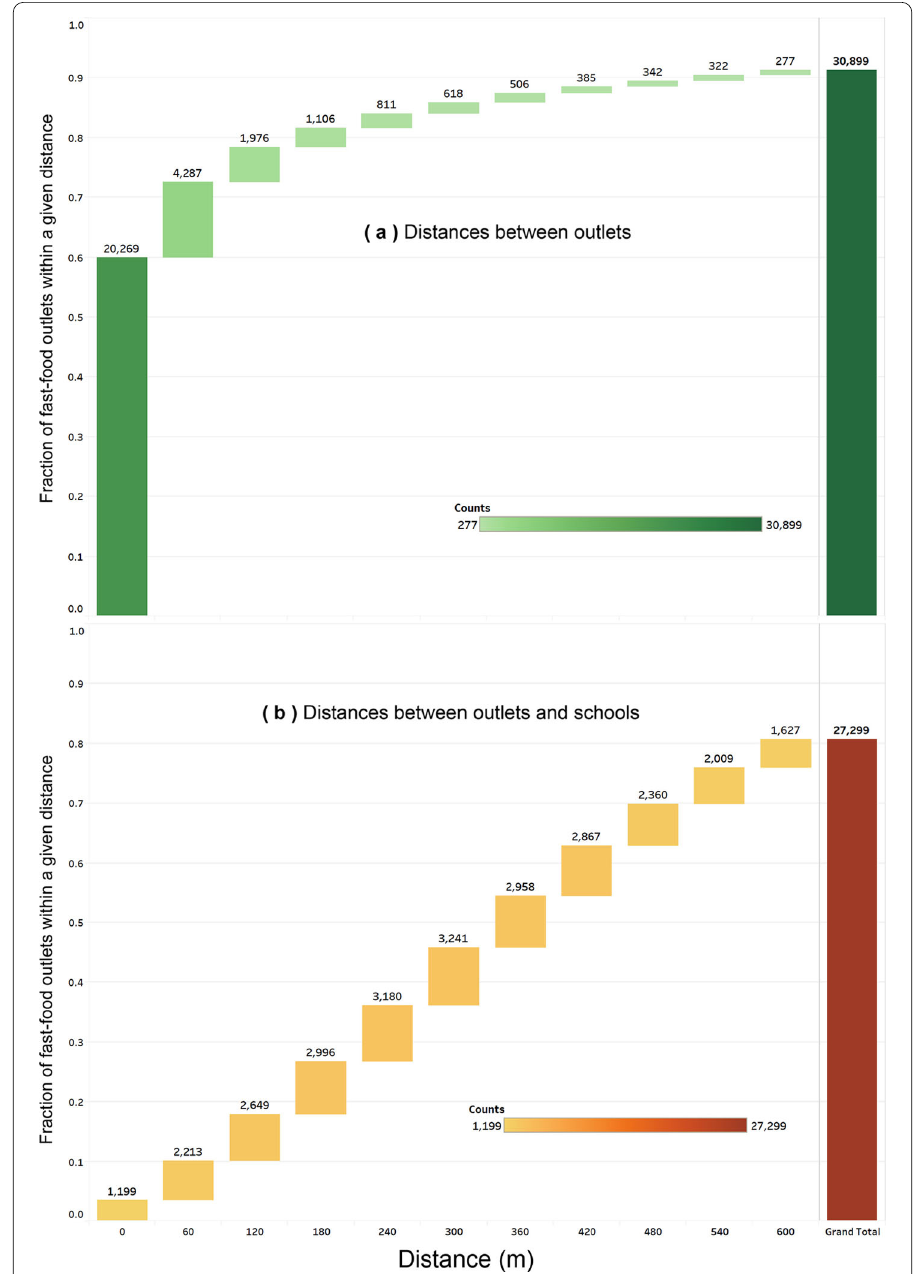
Figure 11 Distribution of distances (in meters) between outlets ( a ) as well as between outlets and schools ( b ). The a -axis goes up to 600 m as it is the largest value encountered in current zoning policies regarding fast-food outlets and schools in England. AnexpandedversionofthefigurealsousingEuclideandistancesis availableon https://osf.io/gn3f2/